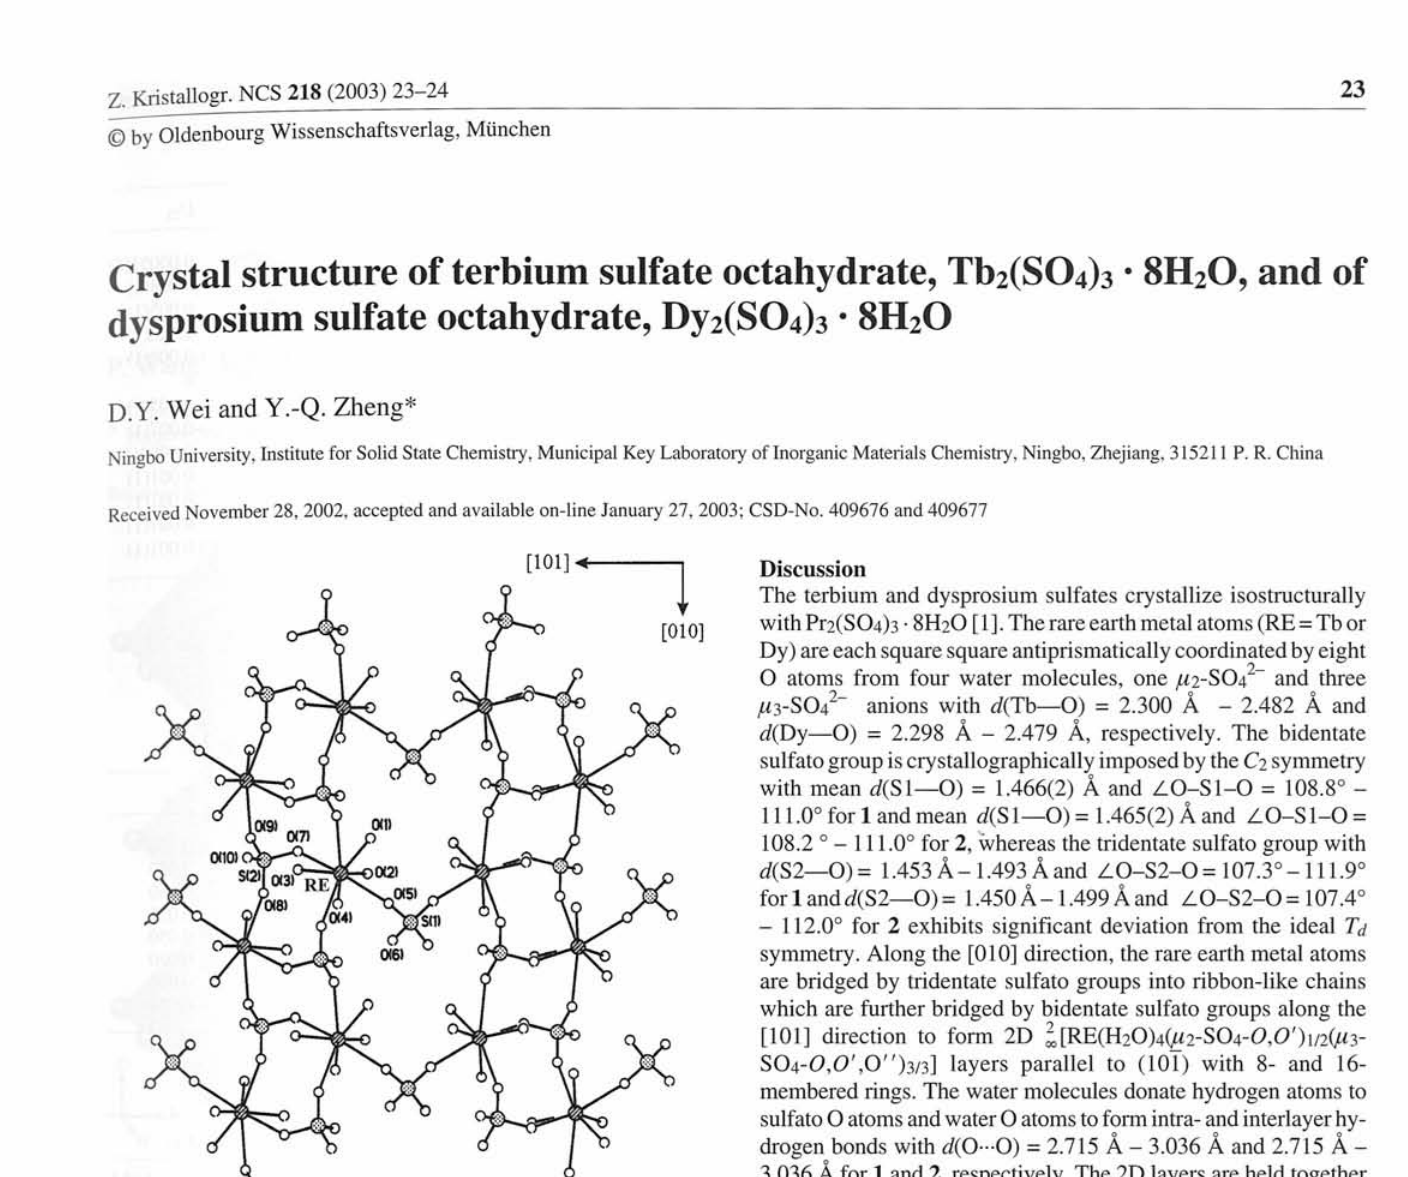
Table 1. Data collection and handling. Crystal: